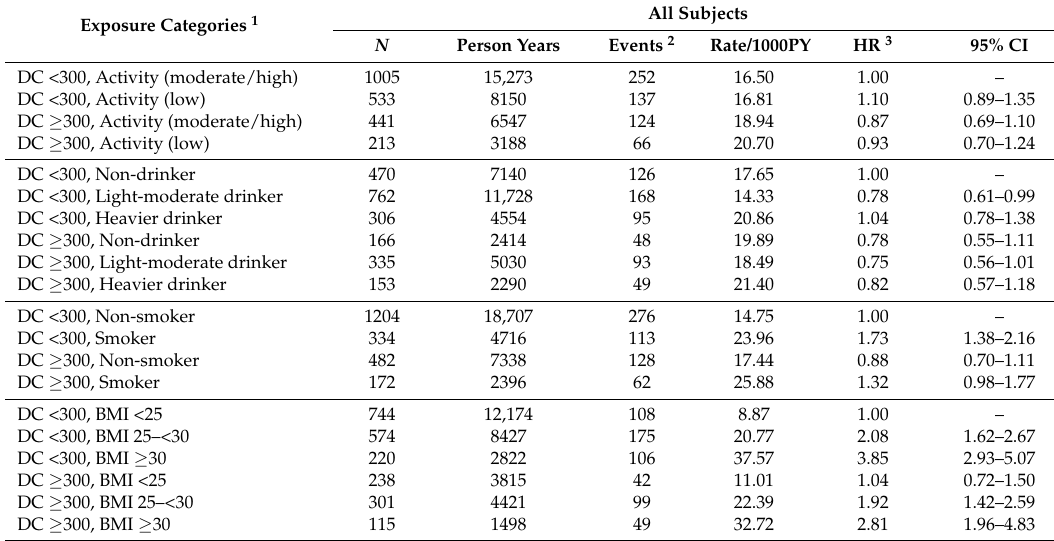
Table 4. Rates and adjusted hazard ratios for T2DM or IFG according to combined intakes of dietary cholesterol and other